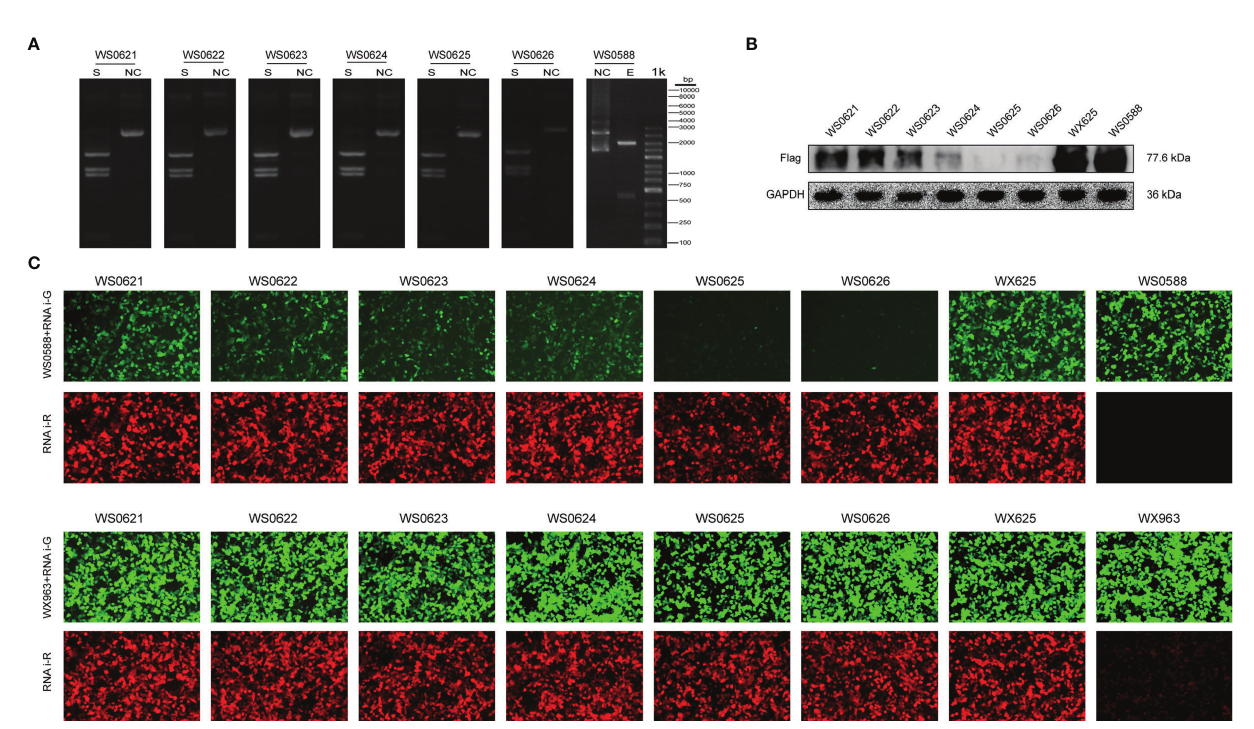
FIGURE 6 | In vitro CMPK2 target screening. (A) Plasmid digestion validation for WS0588 and WS0621-0626 using the following restriction sites: Sma l (S) and Kpn I – Bam HI (E). Molecular weight was determined using a 1-kb DNA Ladder (from bottom to top: 100 bp, 250 bp, 500 bp, 750 bp, 1 kb, 2 kb, 3 kb, 4 kb, 5 kb, 6 kb, 8 kb, and 10 kb). The pictures in panel A represent each plasmid treated with restriction enzyme (S) and unrestricted controls (NC). The restriction site was Sma l for WS0621, WS0622, WS0623, WS0624, WS0625, and WS0626, and the restriction site of WS0588 was Kpn I – Bam HI. The size of each band corresponded with the expected value. (B) Western blotting of the interference group WS0621 – 626, the interference control sample WX625, and the overexpression sample WS0588 Western blotting bands. The fl ag signal was present at 77.6 kDa. WS0625 and WS0626 proteins were least expressed, which indicated the best interference effect. (C) The interference group WS0621 – 626, the interference control sample WX625, and the overexpression sample WS0588 were co-transfected with 293 T cells in vitro . Red fl uorescence represents the expression of interfering plasmids. Green fl uorescence represents overexpression of the target gene plasmid. In the experimental group, the green fl uorescence was signi fi cantly reduced for the WS0625 and WS0626, which indicated that these targets had strong interference ability. The negative control WX625 had no knockout ability. The green fl uorescence in the interference control sample WX625 and overexpression sample WS0588 were signi fi cantly enhanced.